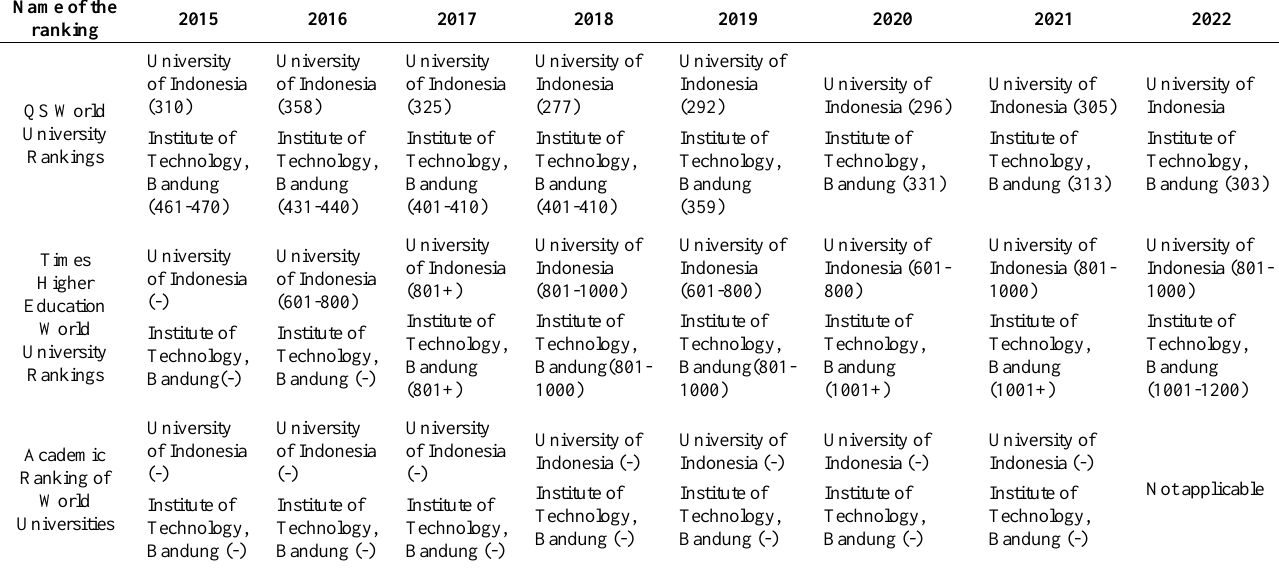
Table 2. Ranking of the two biggest universities of Indonesia in ratings for